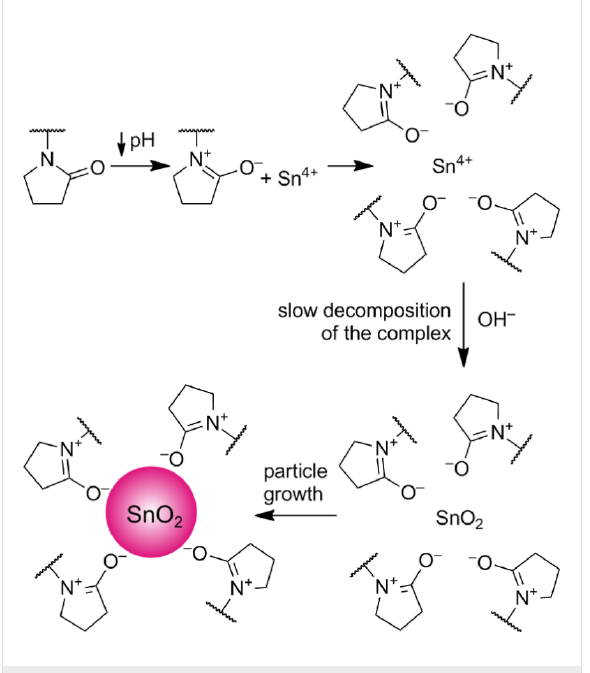
Figure 10: Diagram of the process of SnO 2 particle formation in the presence of